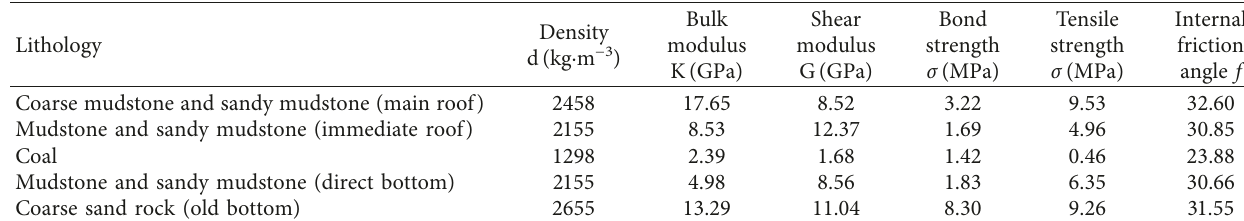
Figure 6: FLAC 3D schematic diagram. Table 1: Rock mechanics